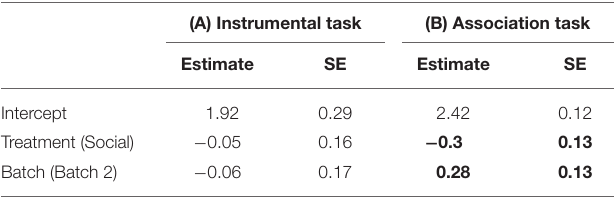
TABLE 1 | Estimates and standard errors (SE) from a generalized linear model (GLM) examining the effects of a lizard’s treatment group (social learning or control) on the mean number of trials it took for a lizard to learn the (A) instrumental task ( N = 28), (B) association task ( N = 28). (A) Instrumental task (B) Association